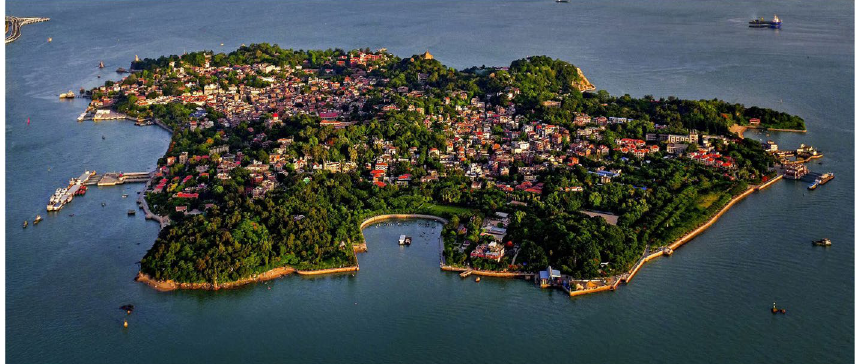
Fig. 1 Bird’s eye view of Kulangsu (Source: KULANGSU Administrative Committee. whc.unesco.org/en/documents/158147. Accessed 5 November